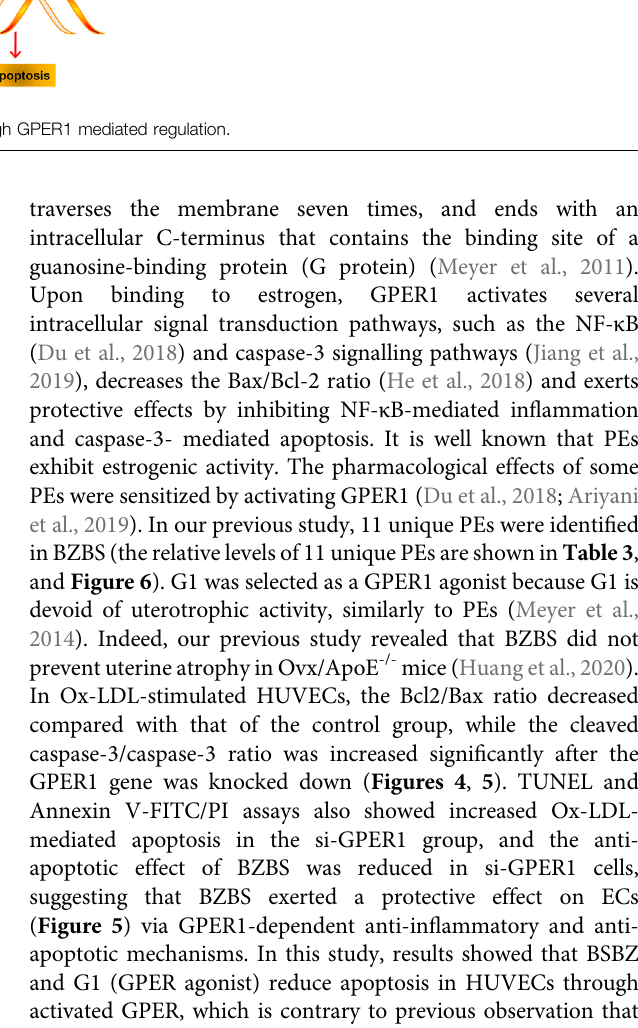
Frontiers in Pharmacology |